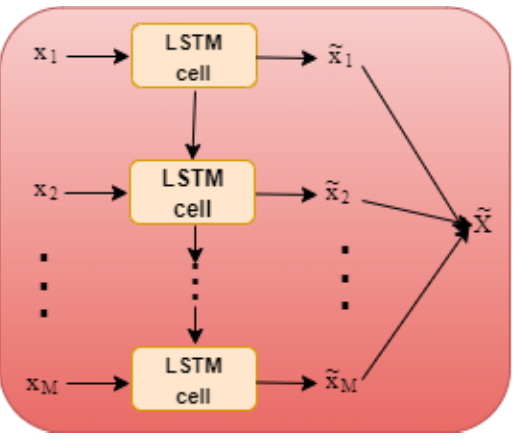
Figure 10. LSTM block